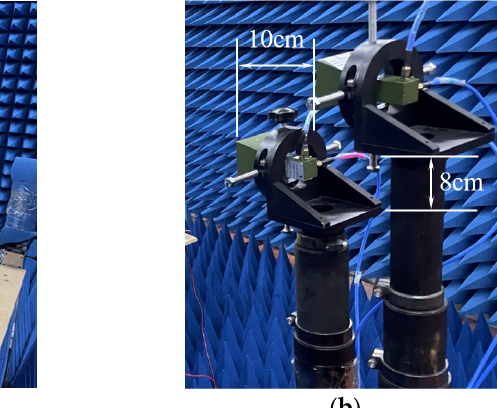
Figure 8. Experimental setup of electric fields. ( a ) Measurement setup and environment. ( b ) Relative position of the antennas.